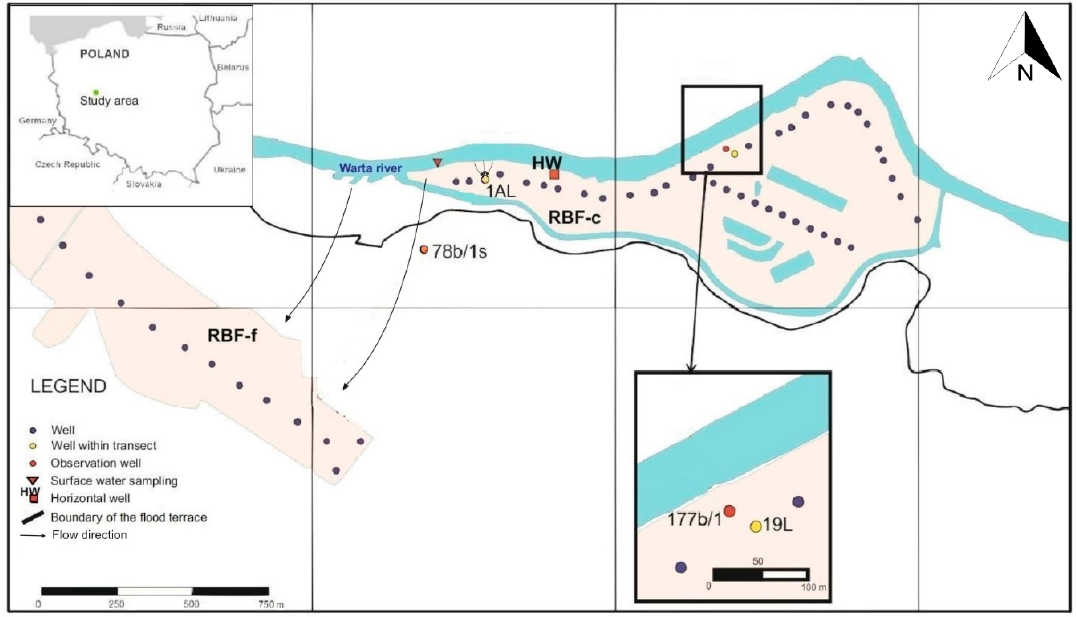
Figure 1. Situation map of the study area. RBF: riverbank filtration; RBF-c: wells on the flood terrace; RBF-f: wells on the higher terrace; and HW: horizontal well. [2] modified.